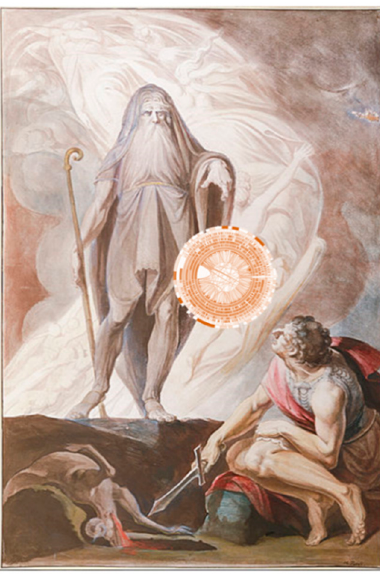
Figure 6. Teiresias and the Cancer Genome Atlas. (Adapted from: https://www.thoughtco.com/).